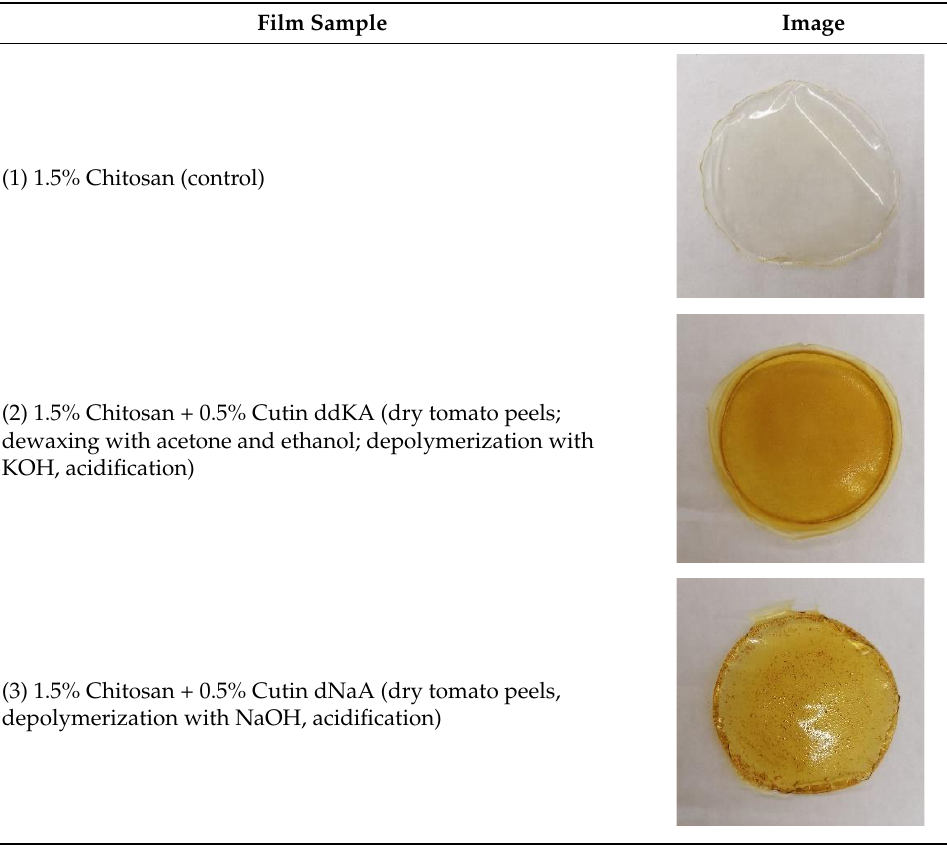
Table 7. Composition of film-forming solution and visual appearance of the films produced in this work.